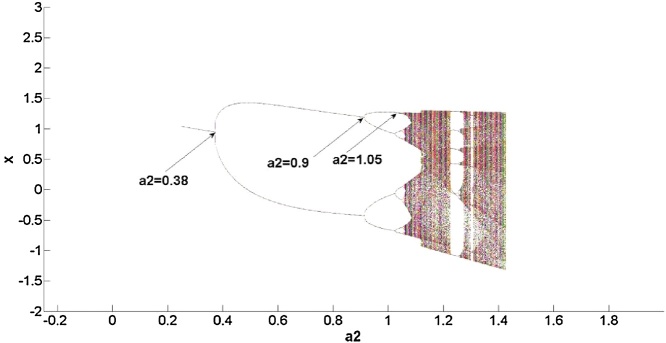
Bifurcation at situation 1.